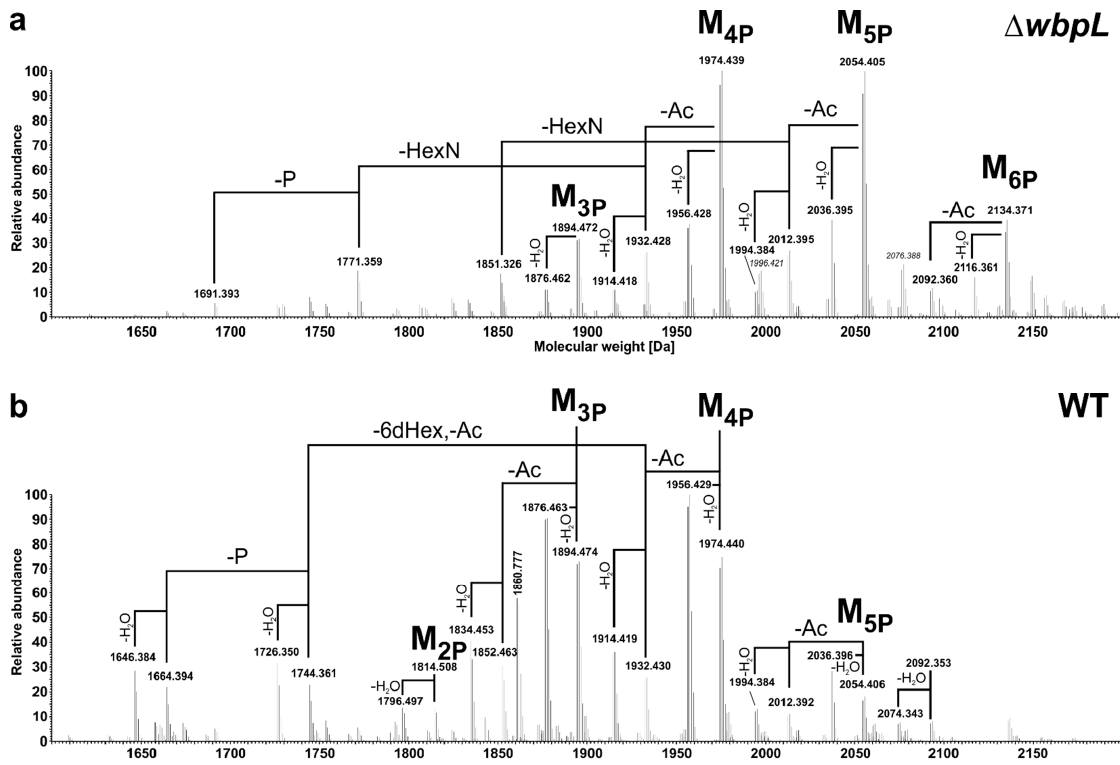
Figure 5. MS analysis of core-OS preparations obtained by hydrolysis with 1% acetic acid from lipopolysaccharide (LPS) of Δ wbpL and wild-type Pst DC3000. Molecular species distribution in the mixture of core-OS preparations (OS HOAc ) obtained after treatment of LPS isolated from Pst DC3000 Δ wbpL ( a ) and wild-type ( b ) with 1% acetic acid. Charge-deconvoluted spectra of the MS-analysis performed in negative ion mode are depicted. Molecular masses given in italic style represent sodium ( Δ m = 21.98 Da) adduct ions of the respective base peak. Despite the known complexity of such core-OS preparations due to the high degree of structural heterogeneity (e.g., caused by two outer core glycoforms (w/wo HexNAc), varying degree of phosphorylation, and anhydro versions of all molecules) we analyzed the OS HOAc preparation derived from Pst DC3000 Δ wbpL by NMR, especially aiming to